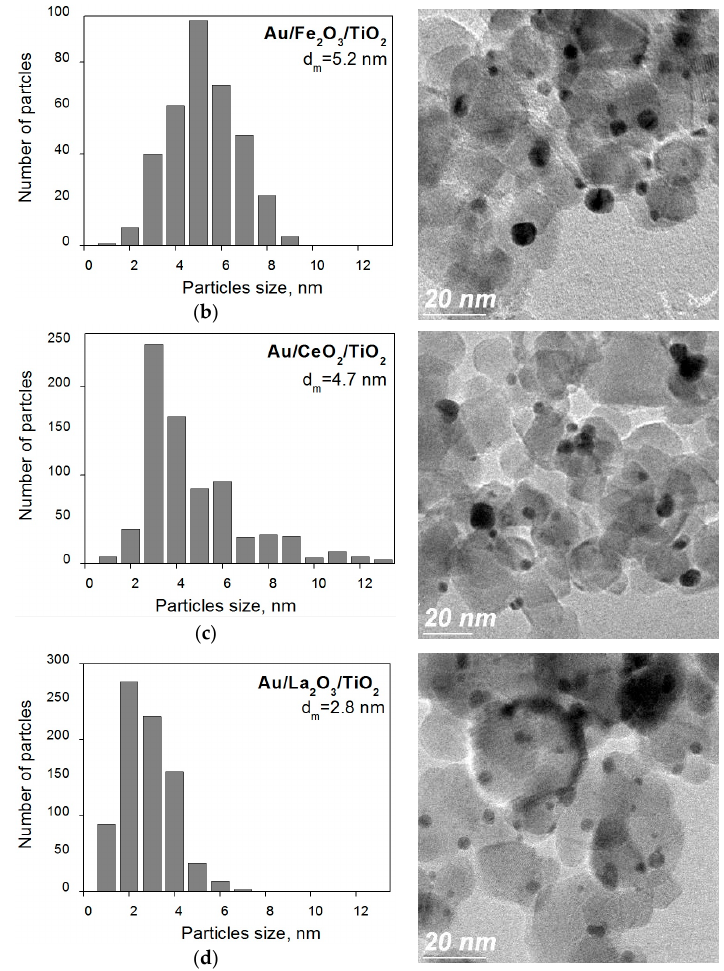
Figure 1. TEM images of Au/TiO 2 ( a ) and Au/M x O y /TiO 2 (M x O y = La 2 O 3 , CeO 2 or Fe 2 O 3 ) ( b – d ) catalysts pretreated in H 2 atmosphere at 300 °C.